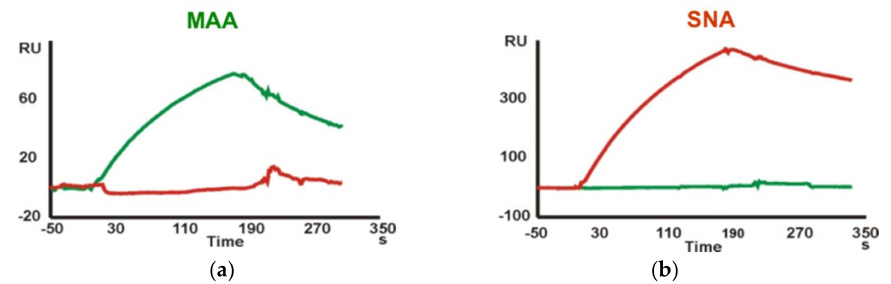
Figure 3. Binding sensorgrams showing the different carbohydrate specificity of both lectins (( a ) MAA; ( b ) SNA) to their specific sugar epitopes (Neu5Ac- α 2,3-lacNAc and Neu5Ac- α 2,6-lacNAc in green and red trace,